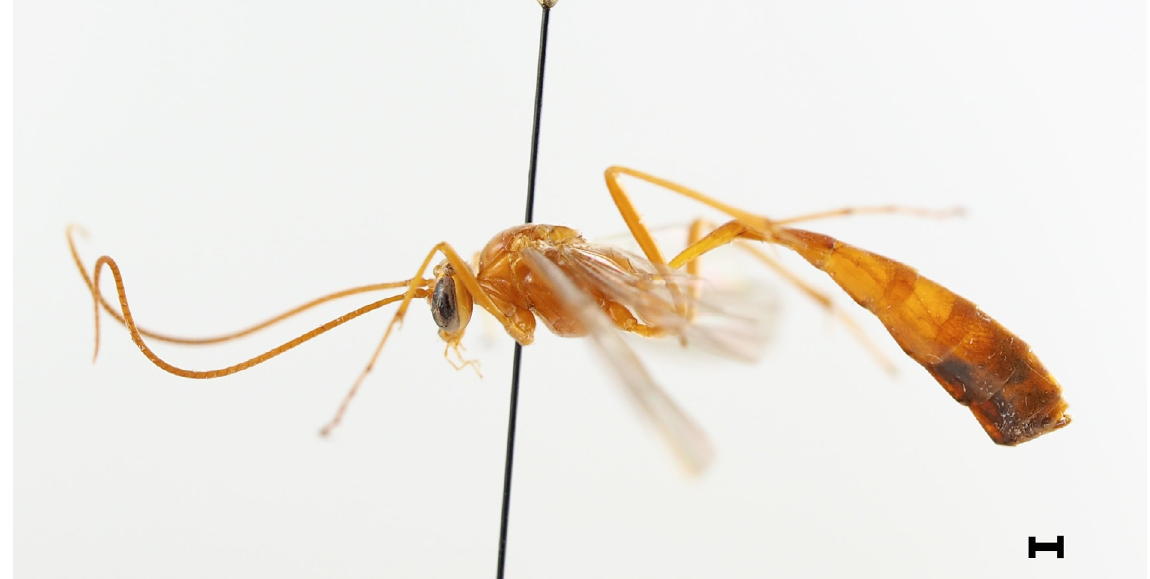
Fig. 32. Ophion ellenae Johansson sp. nov., paratype, ♀ (MZLU Type no. 6370:1). Scale bar = 1